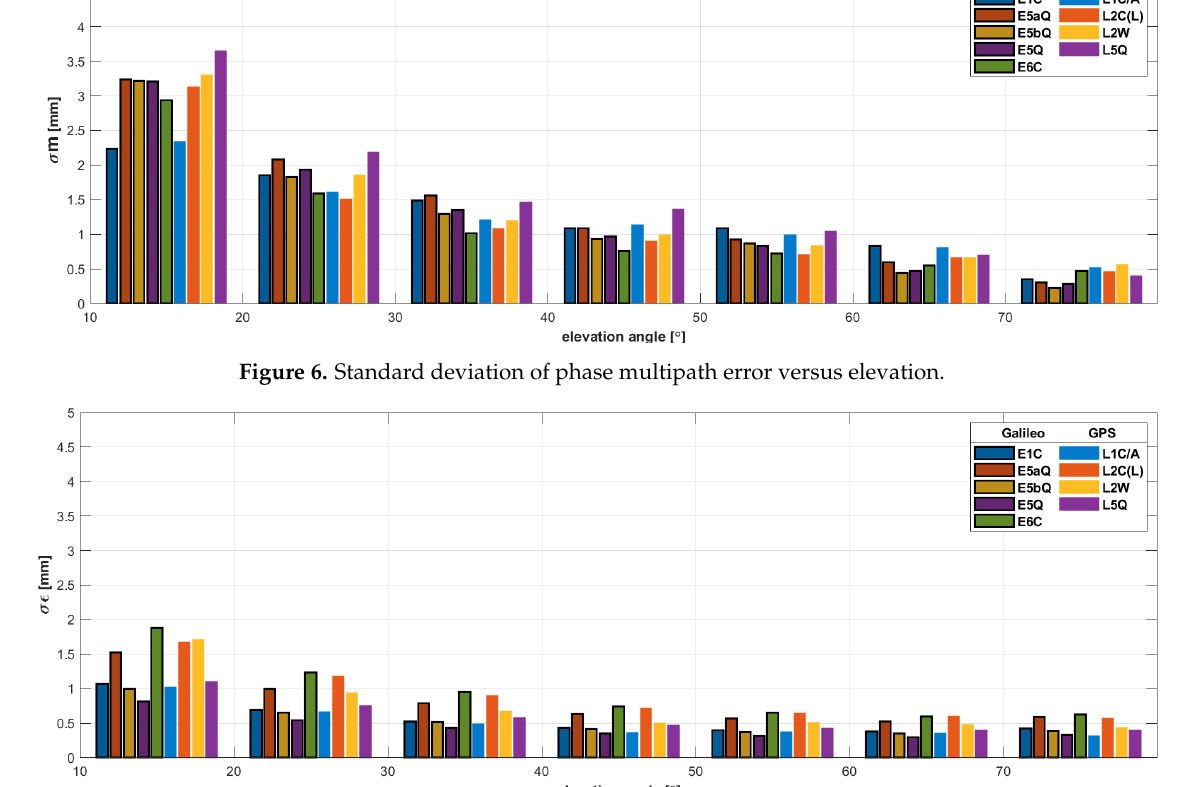
Figure 7. Standard deviation of phase noise error versus